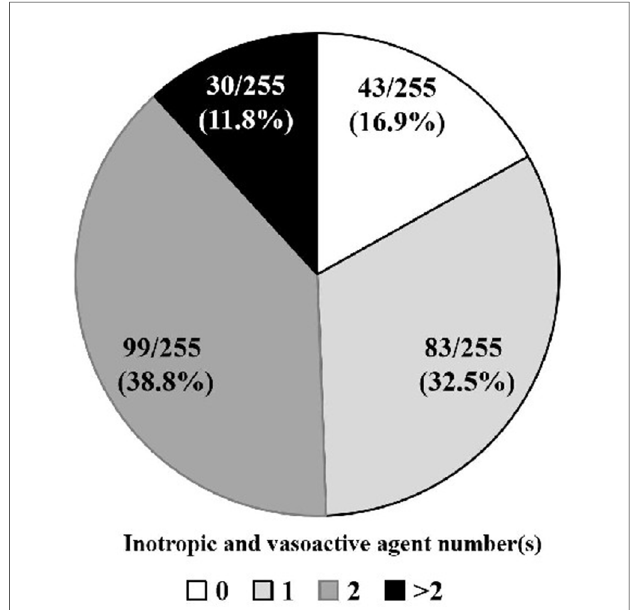
FIGURE 6 Administration of inotropic and vasoactive agents at the end of the operation. Almost all the patients were sent to ICU with at least one kind of inotropic or vasoactive agent (212/255, 83.1%). ICU, intensive care unit.